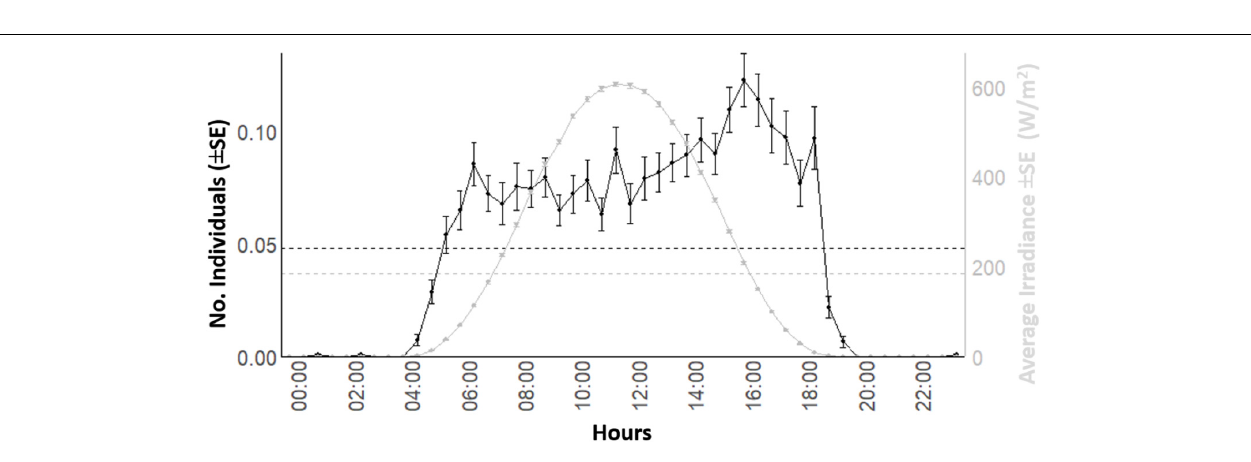
FIGURE 5 | Global waveform analysis output plot for the D. dentex visual count and solar irradiance time series from 8 years (i.e., 2012–2019) of monitoring at the OBSEA video platform. The dashed horizontal line is the